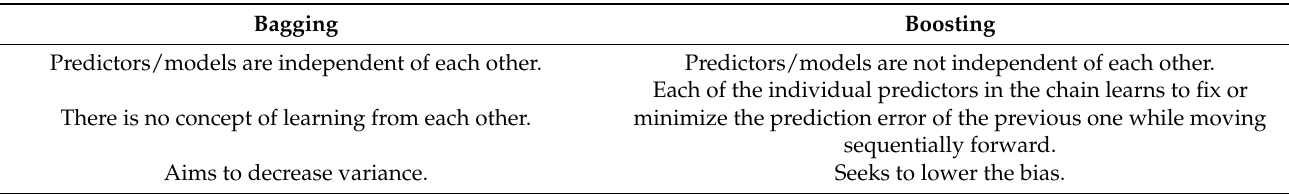
Table 1. Main differences between Bagging and Boosting.